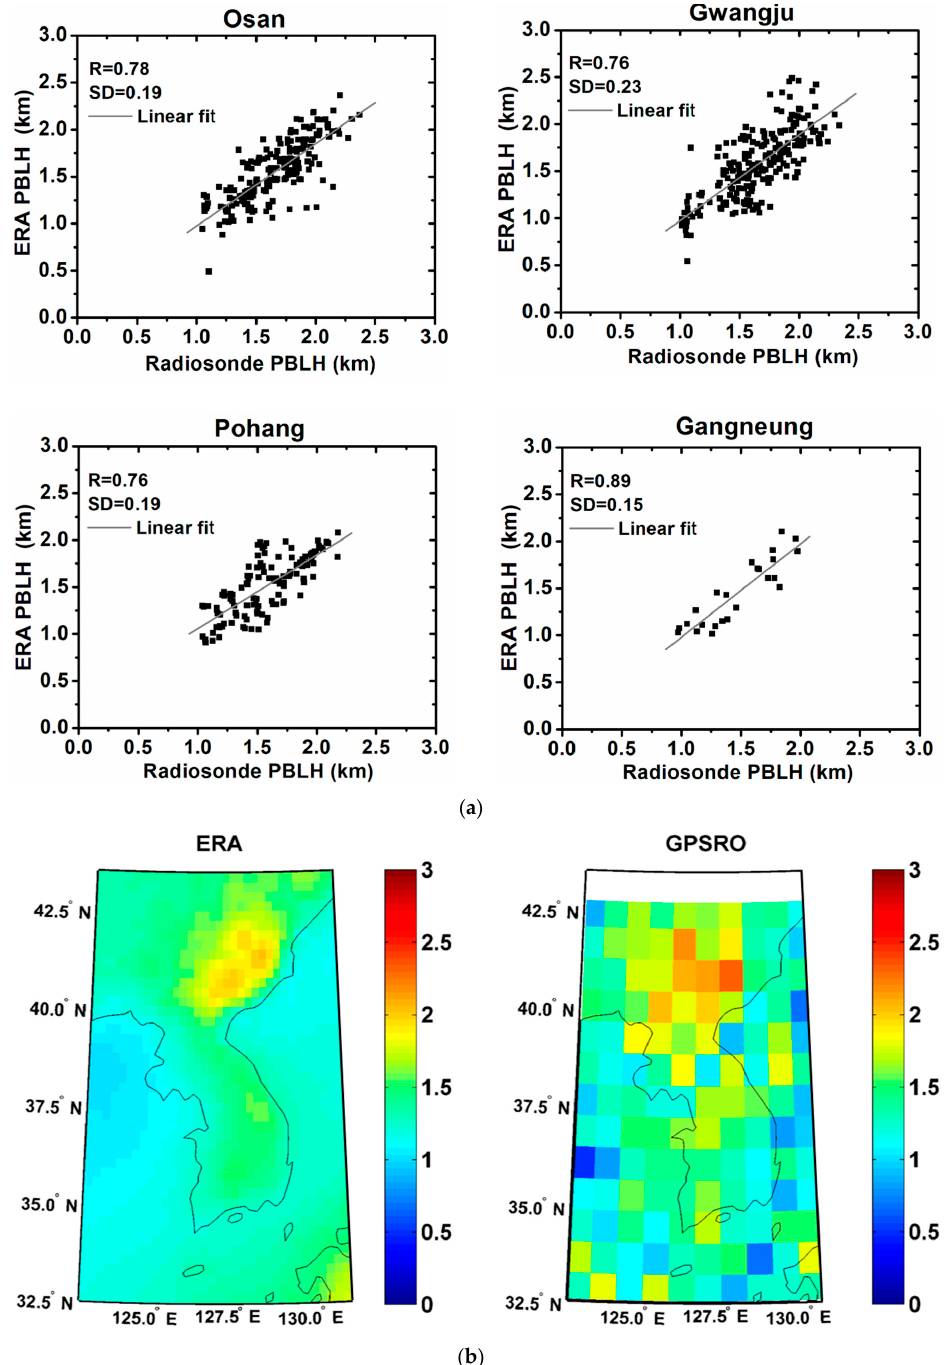
Figure 2. ( a ) Scatter plots of planetary boundary layer height (PBLH) derived from ERA5 and sounding datasets over four different geographical locations (Osan, Gwangju, Gangneung, and Pohang). ( b ) PBLH derived from ERA5 and global positioning system radio occultation (GPSRO) for the year 2008.